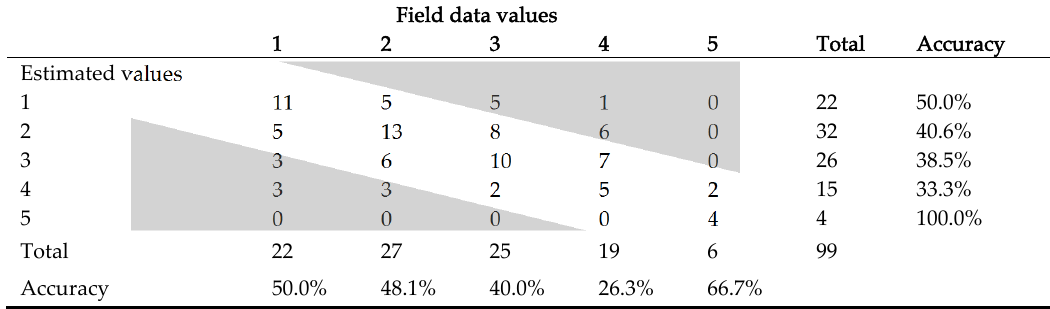
discriminant analysis (LDA). survey mean field data values versus values estimated from the airborne laser scanning (ALS) linear